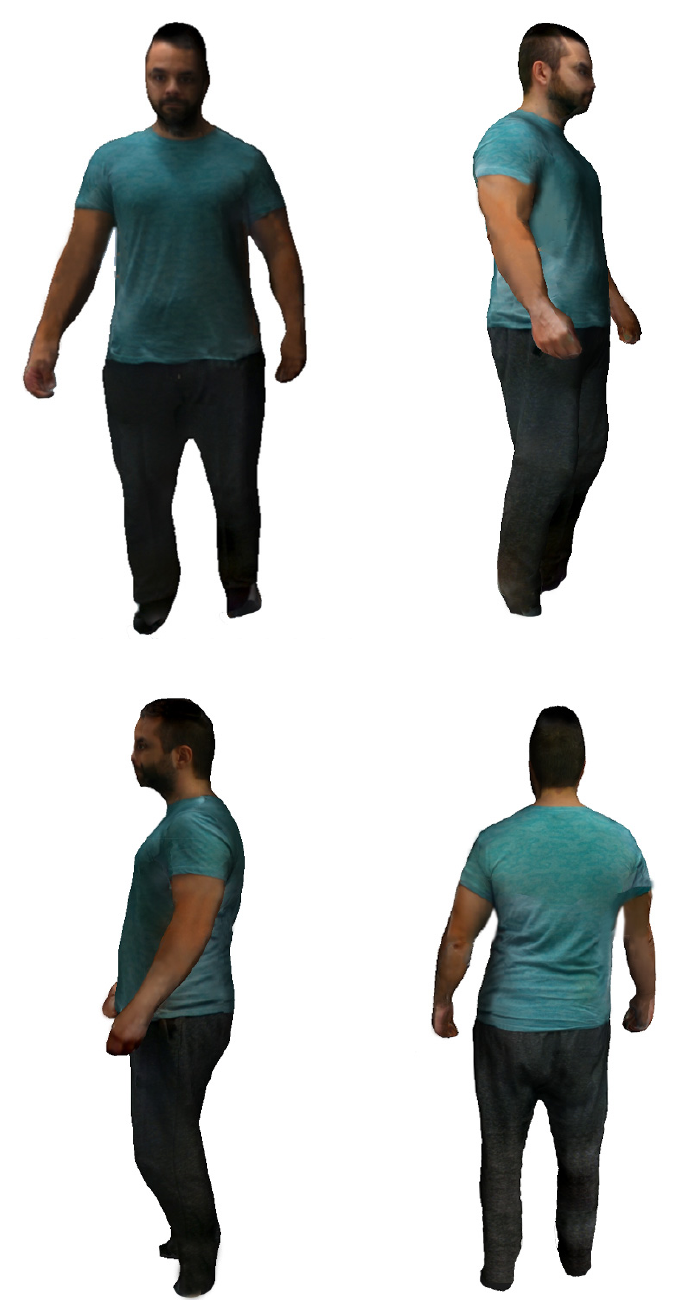
Figure 12. Di ff erent views of the same textured body Figure 12. Different views of the same textured body model.